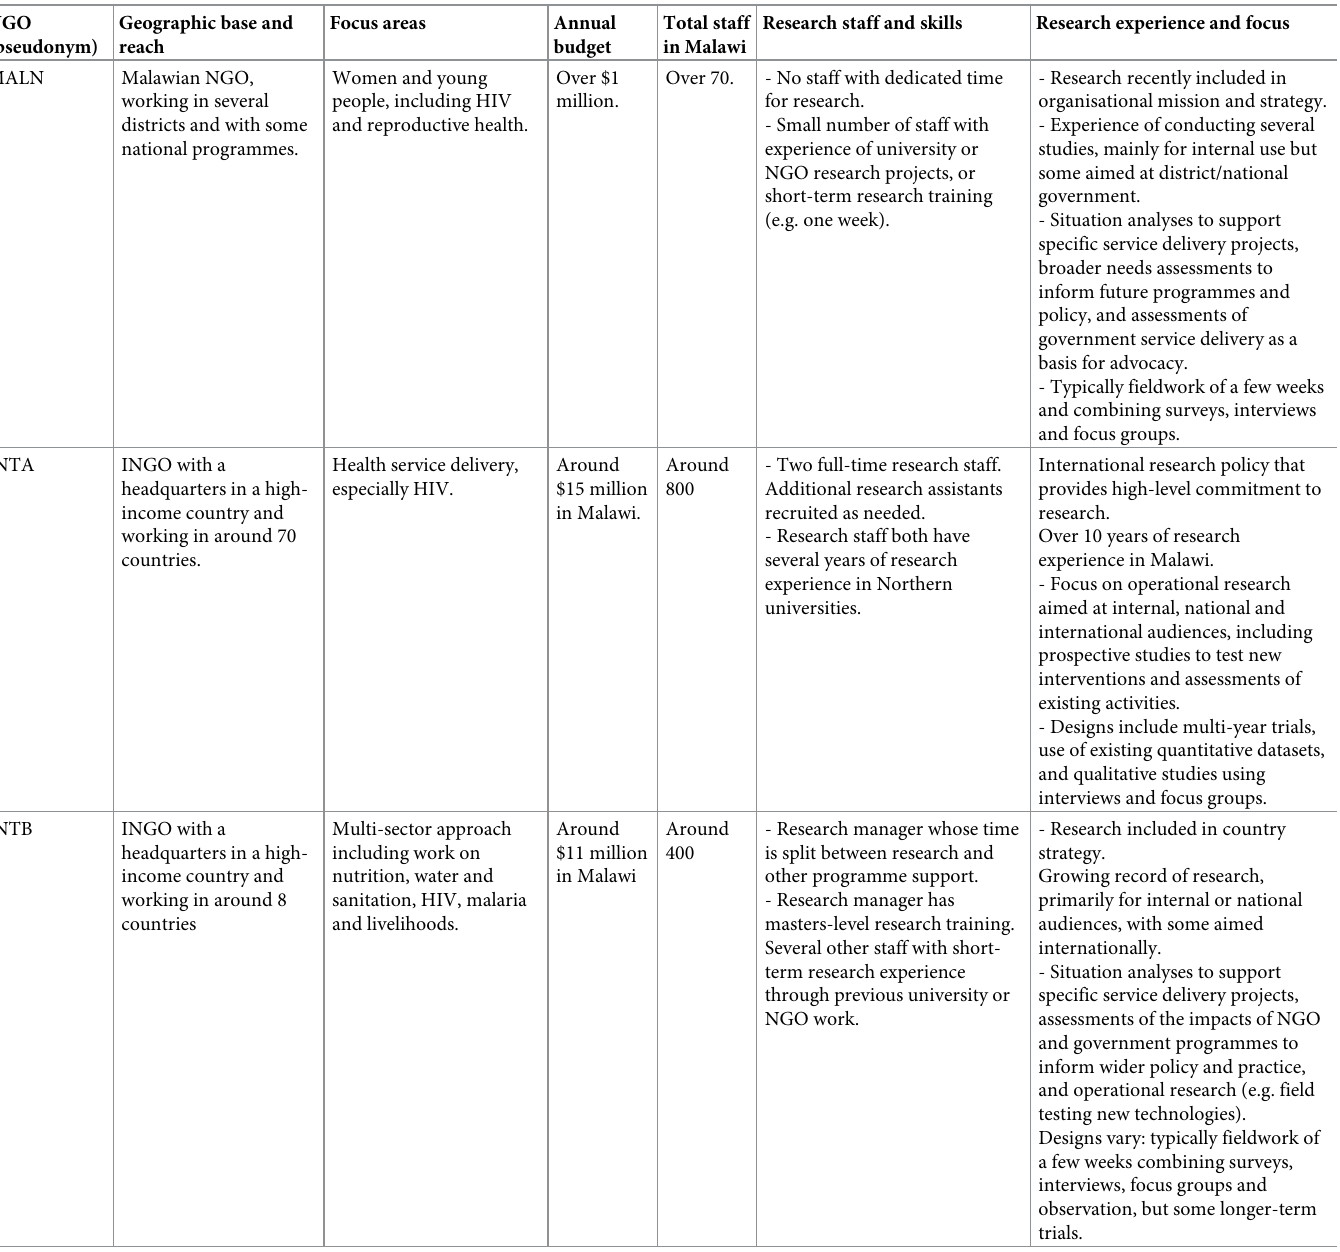
Table 1. Case NGO